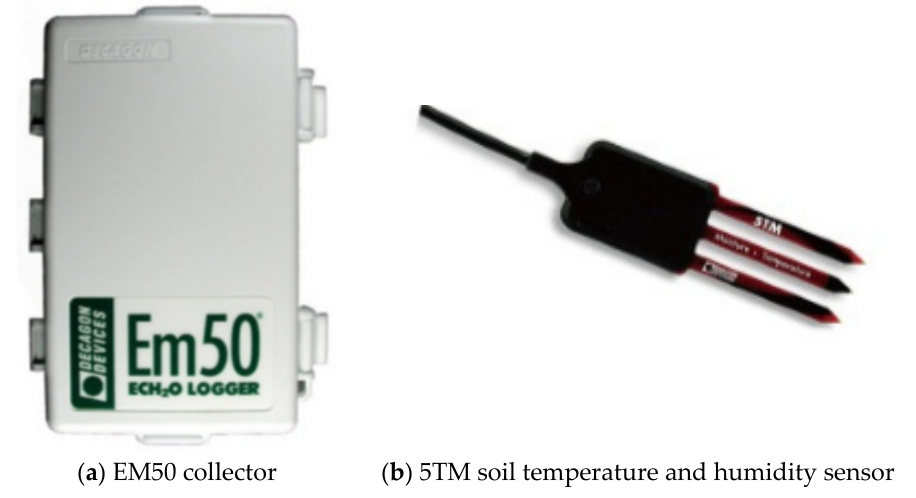
Figure 3. Testing instrument. Figure 3. Testing